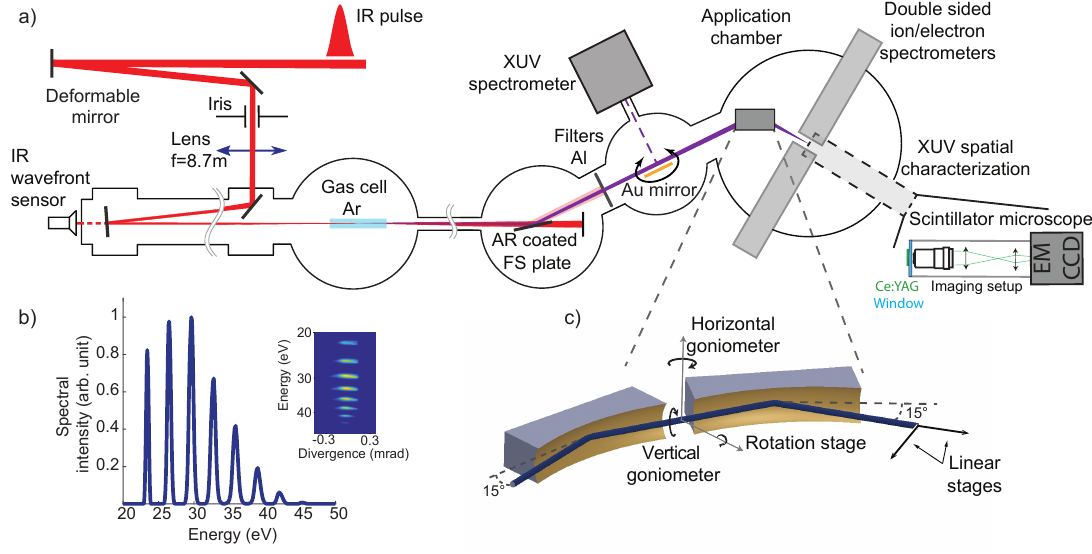
Figure 1. ( a ) Scheme of the intense extreme ultraviolet (XUV) beamline; ( b ) typical high-order harmonic generation (HHG) spectrum; and ( c ) double toroidal mirror setup in a Wolter configuration. The black lines indicate the translation axes (straight solid arrows) and the pivoting axes for the revolutions (curved solid arrows). AR: anti-reflection; FS: fused